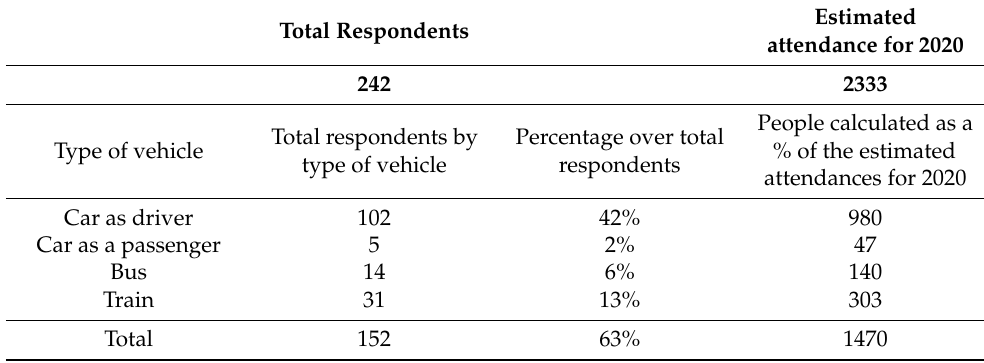
Table 10. Estimates of teaching and administrative staff using the different types of transport in 2020. Total Respondents